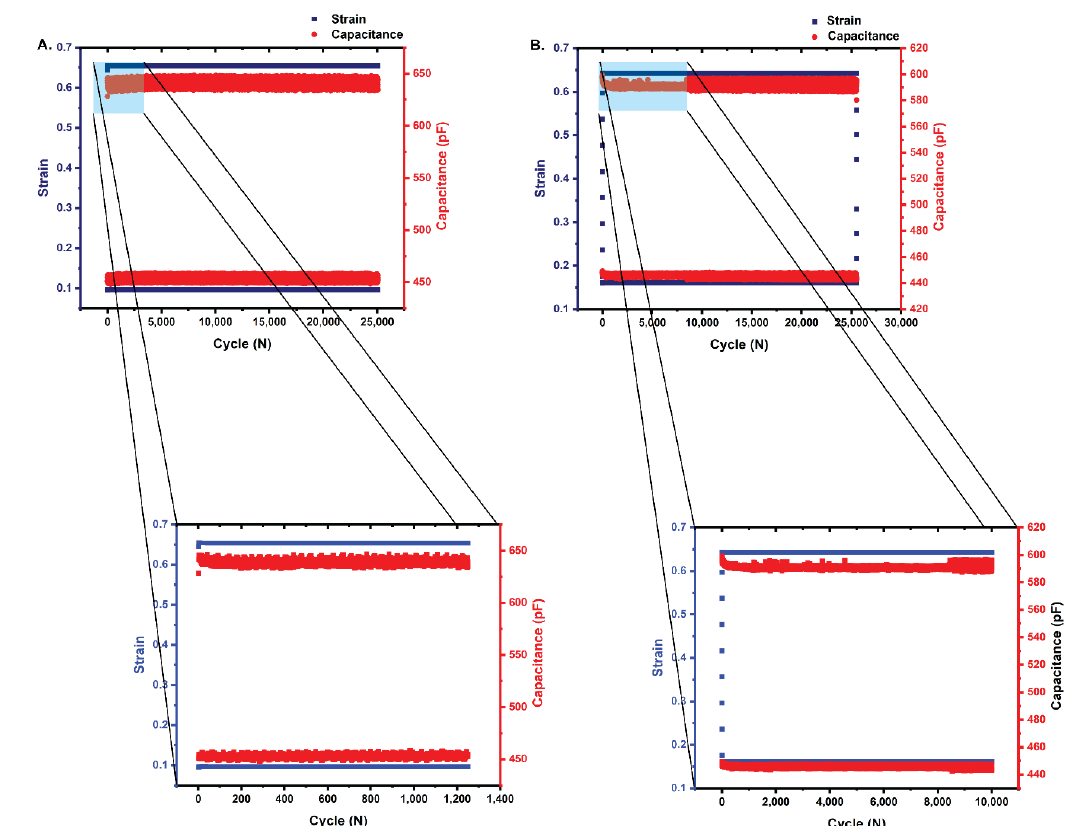
Figure 7. ( A ) Comparison of the peak and valley strain of the first fatigued StretchFABRIC sensor. The strain as measured by the MTS 858 and the capacitance as measured by the sensor are